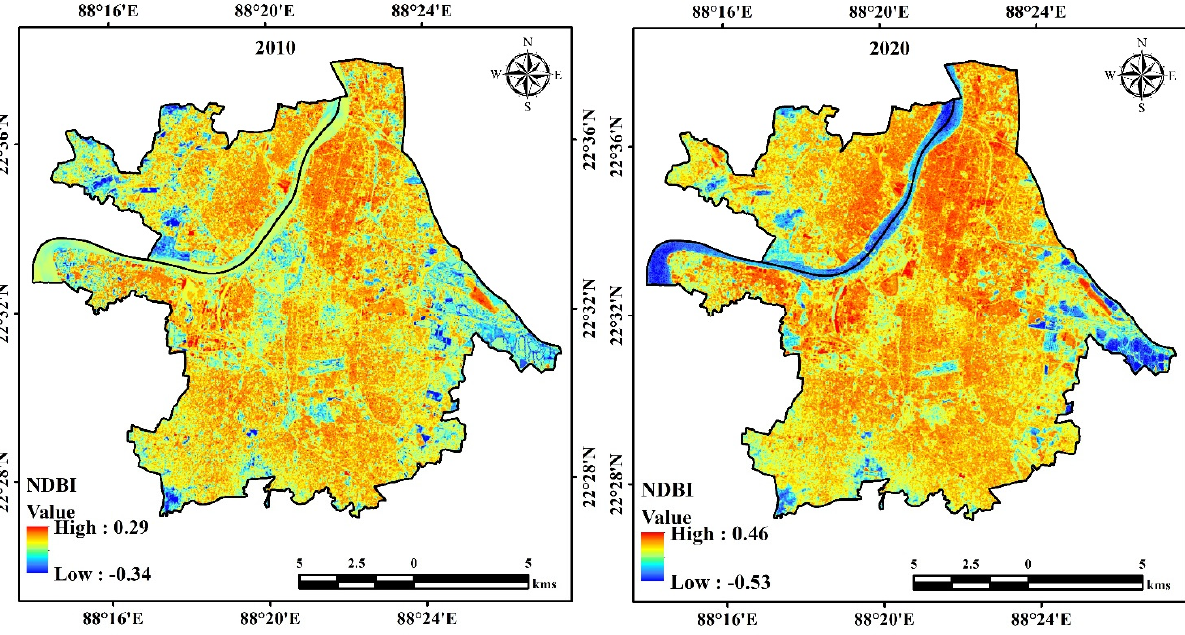
Figure 9. Normalized difference built ‐ up index (NDBI) variation in 2010 and 2020 for West Bengal (Kolkata and Howrah).